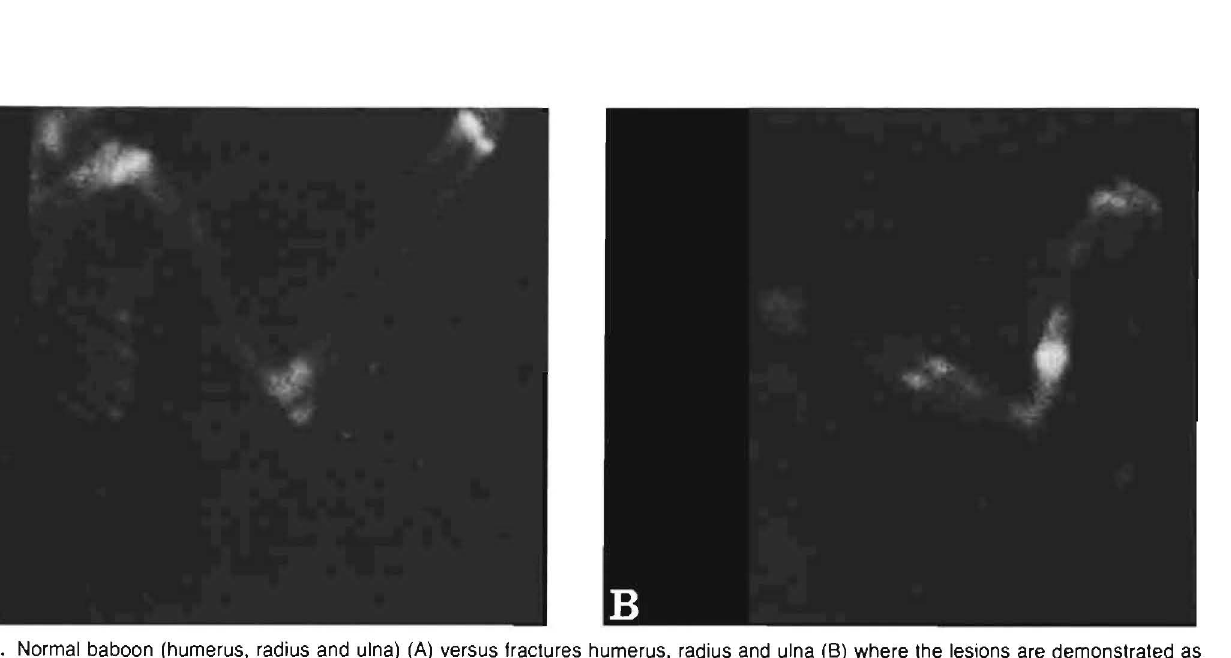
Fig. 2. Normal baboon thorax (ventral) 4 h after intravenous-injec tion of 6mCi 99mTc-labelied methylene diphosphonate (Tc MDP). Note that the areas of active growth (epiphyses of long bones) normally exhibit increased activity.